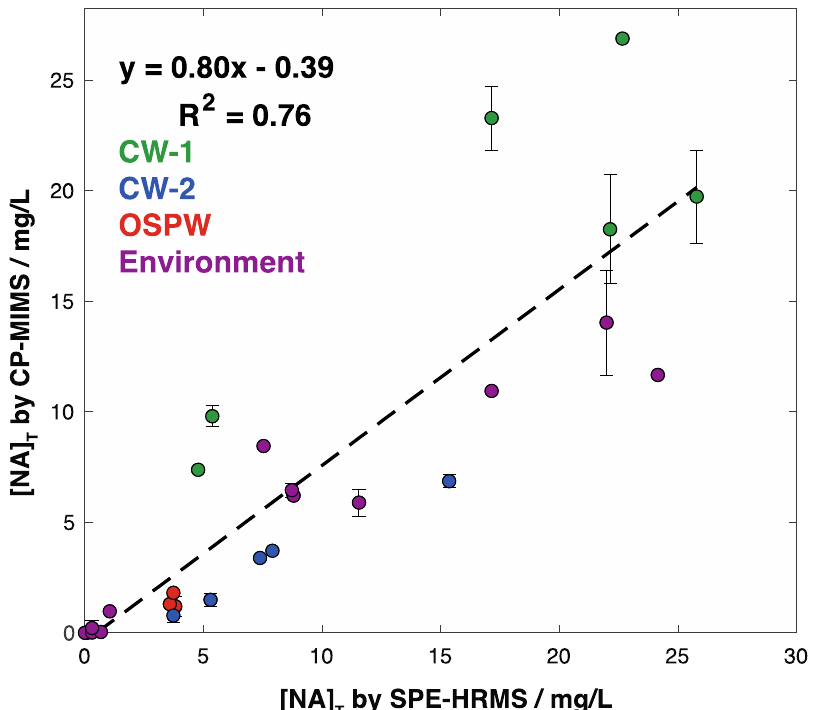
Figure 5. Comparison of quantitative results derived from solid-phase extraction high-resolution mass spectrometry method and CP-MIMS paired with a unit mass resolution QqQ mass spectrometer after scaling results by the fraction of O 2 signal contribution in the calibrant for each method. Quantitative precision on the SPE-HRMS data is estimated at ± 10% from the propagated error of replicate injections and formulae assignment. Vertical error bars indicate the standard deviation across n replicates (Table S5) for CP-MIMS measurements.